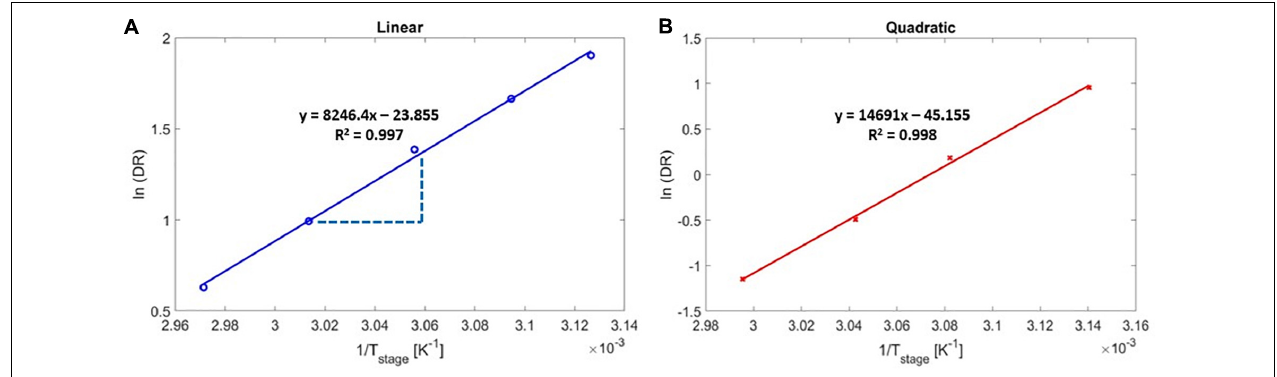
FIGURE 4 | Arrhenius deposition rate as a function of substrate temperature for poly(4-aminostyrene) activation energy calculation in (A) linear, and (B) quadratic regimes.